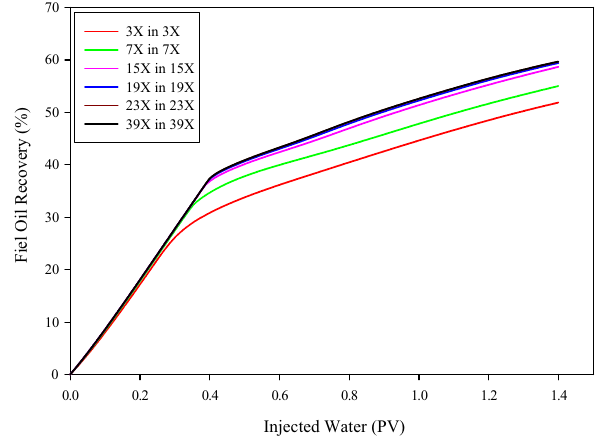
Fig. 11 The sensitivity analysis on the field oil recovery with various grid block size